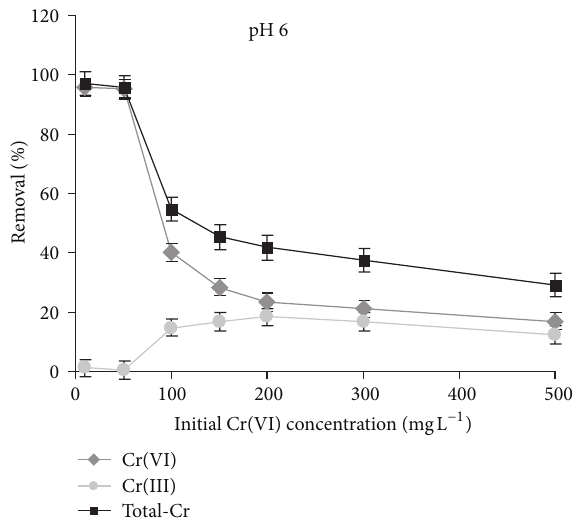
Figure 3: Removal of chromium by micelle-clays complex as total- Cr determined by AAS ( ◼ ) and as Cr(VI) determined by UV-vis method ( Q ). Percent of Cr(VI) reduction to Cr(III) ( ∙ ) is calculated as the difference between total-Cr and Cr(VI) percentages. pH = 6, contact time = 3h, temperature = 25.0 ± 0.2 ∘ C, and adsorbent dosage = 5.0 gL −1 . Data represent averages of triplicates ± SE.